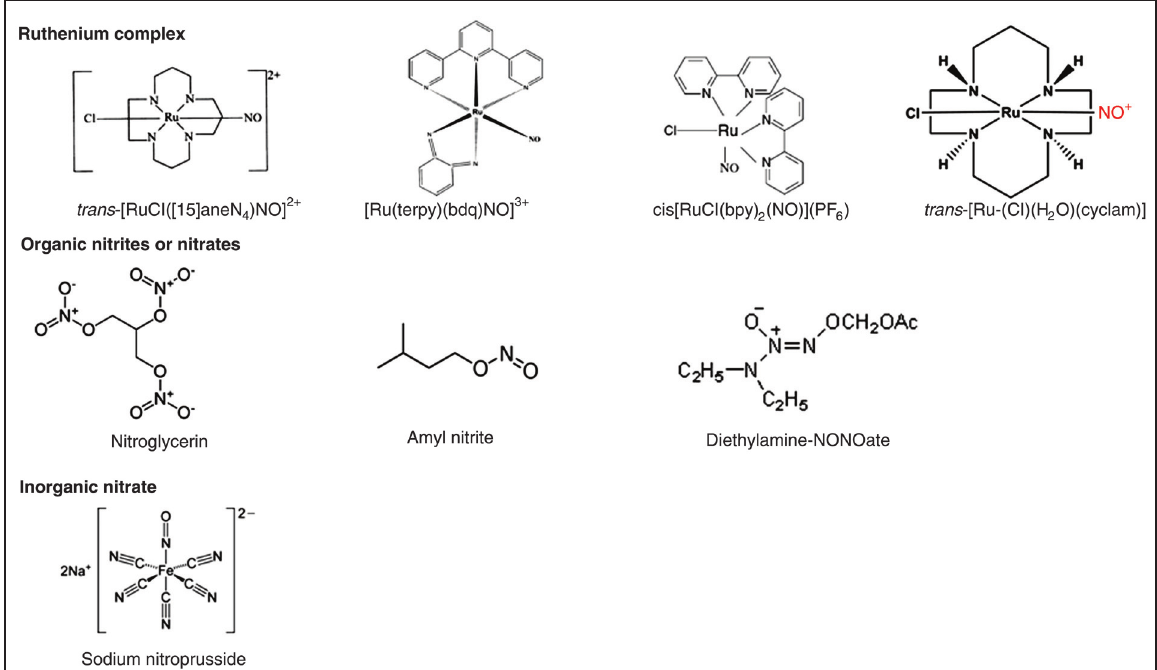
Figure 1. Structures of ruthenium complexes, organic nitrates and inorganic nitrates.